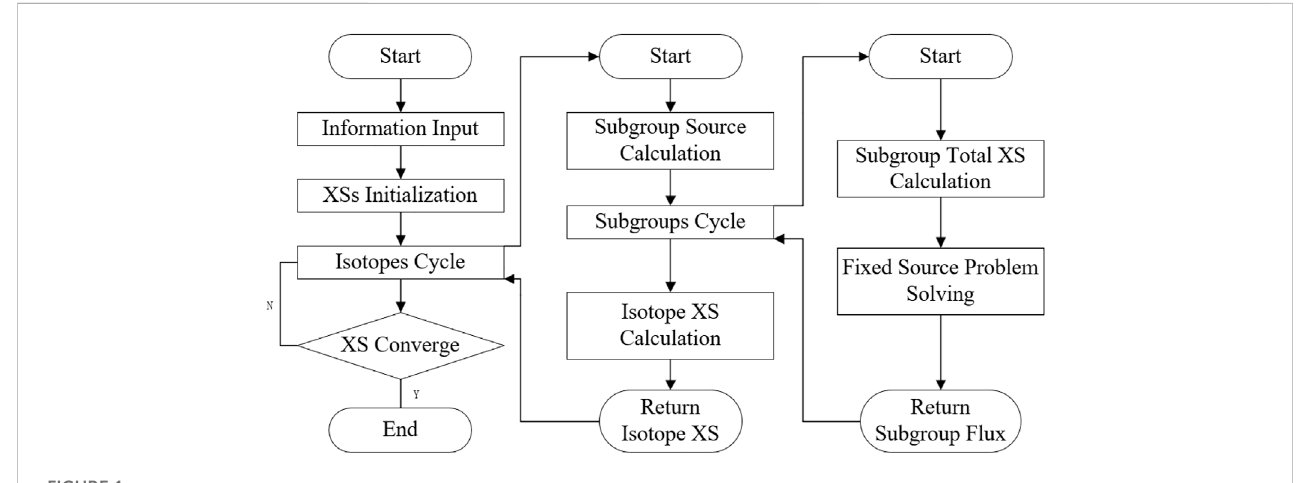
Resonance calculation fl ow